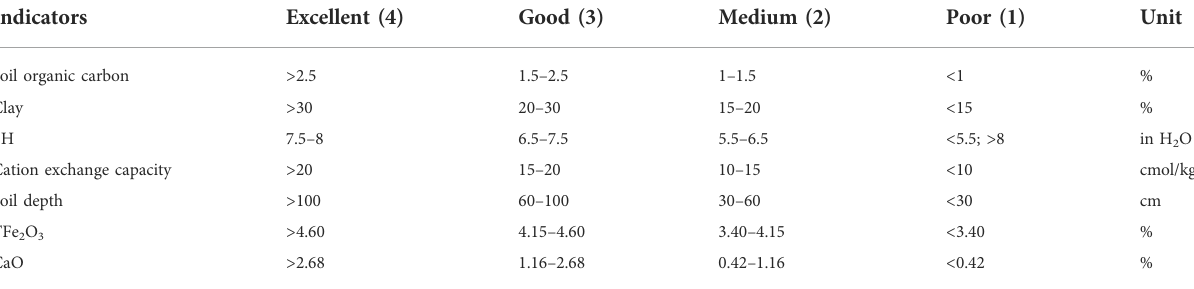
TABLE 2 Threshold levels and scoring of soil indicators (the score for each indicator is given in parentheses).